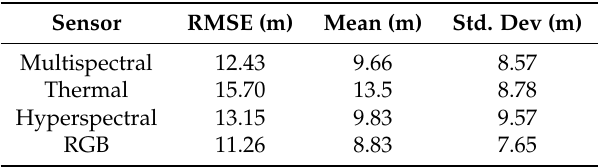
Table 2. 2D Positional spatial accuracy of the sensor pod—OSi orthphotography used to provide GCPs for comparison with the national mapping coordinate